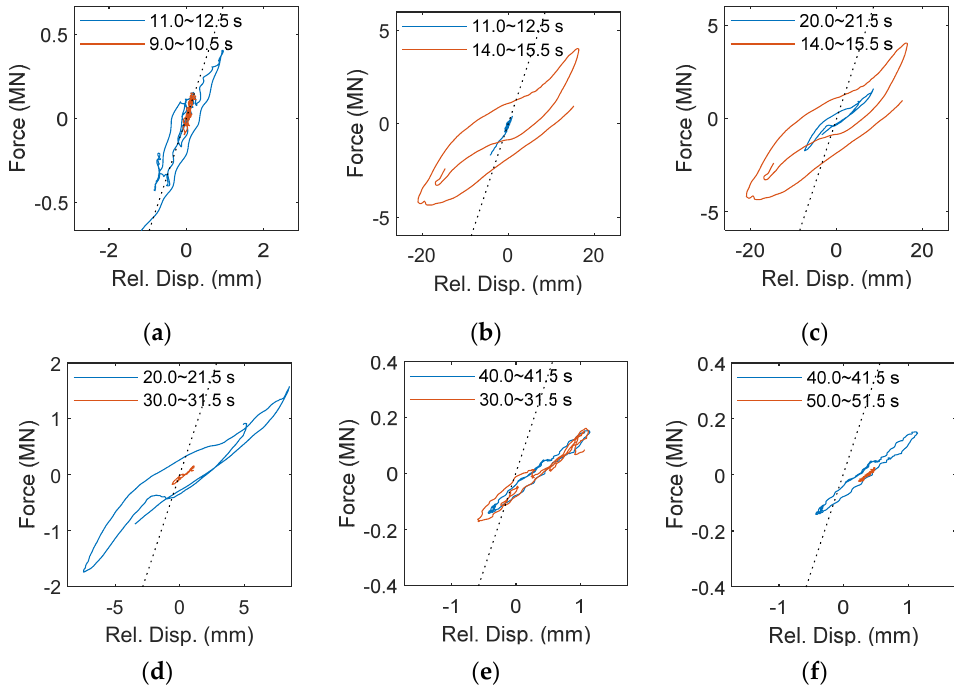
Figure 13. The hysteresis loop of the 10-story RC frame over time. ( a ) 9 to 12.5 s; ( b ) 11 to 15.5 s; ( c ) 14 to 21.5 s; ( d ) 20 to 31.5 s; ( e ) 30 to 41.5 s; ( f ) 40 to 51.5 s.